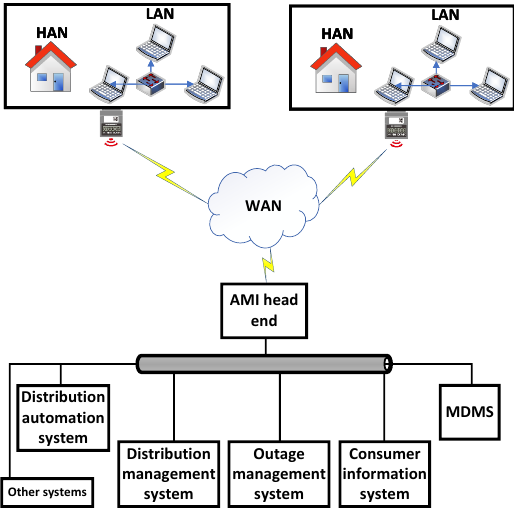
Figure 9. General architecture of